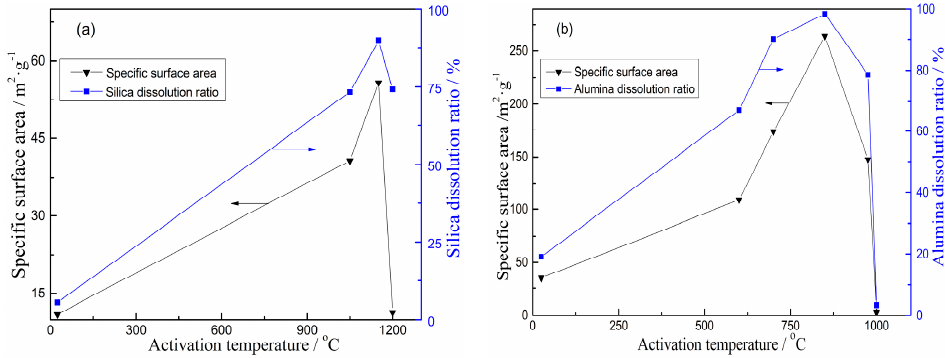
Figure 5. Correlation between the SSA of porous materials and dissolution of activated kaolinite. ( a ) Porous alumina; ( b ) porous silica.